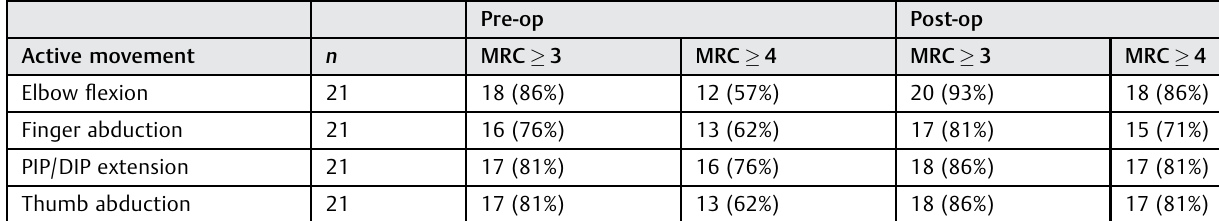
Table 6 Summary of Medical Research Council (MRC) scale for muscle strength grades within the affected extremity